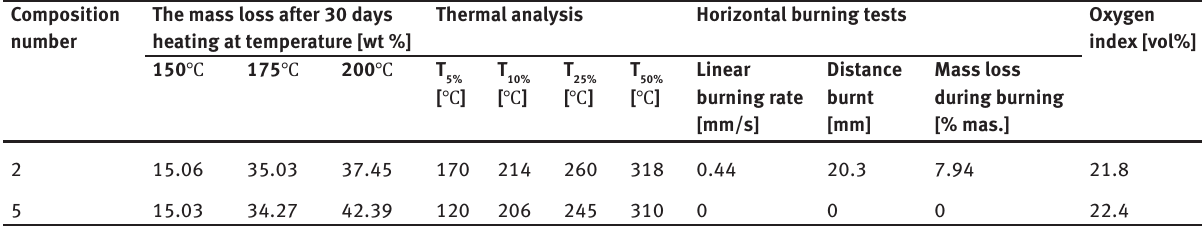
Table 4: Thermal resistance, horizontal burning tests and oxygen index of selected polyurethane foams. Composition The mass loss after 30 days number heating at temperature [wt